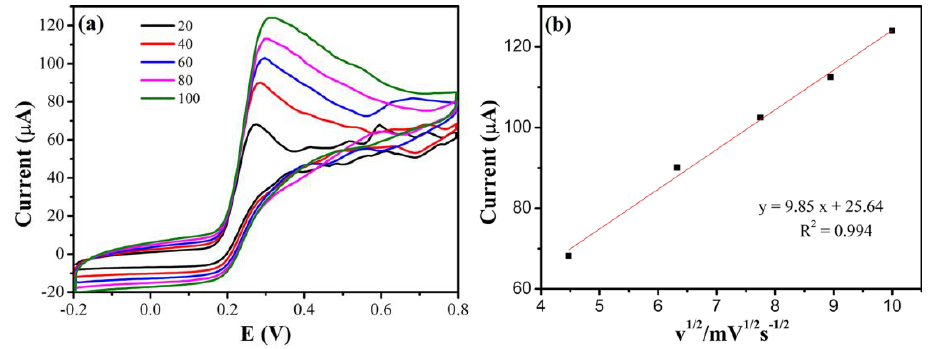
Figure 8. ( a ) CV response of 5 MM of AA for different scan rates ranging from 20 to 100 mV s −1 at Bi 2 S 3 /rGO-3/GCE in 0.1 M PBS solution (pH = 7.0), ( b ) The plots of the peak current vs. square roots of scan rates ( 𝑣 1/2 ).